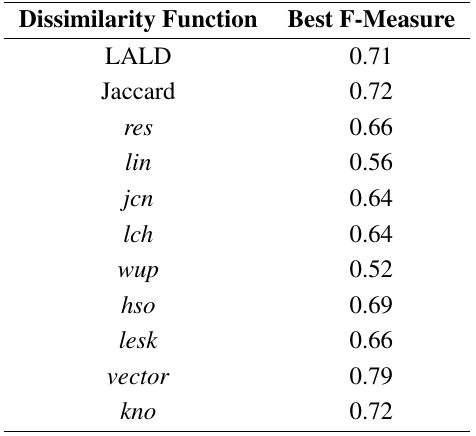
Table 9. Highest F-measures for clustering.